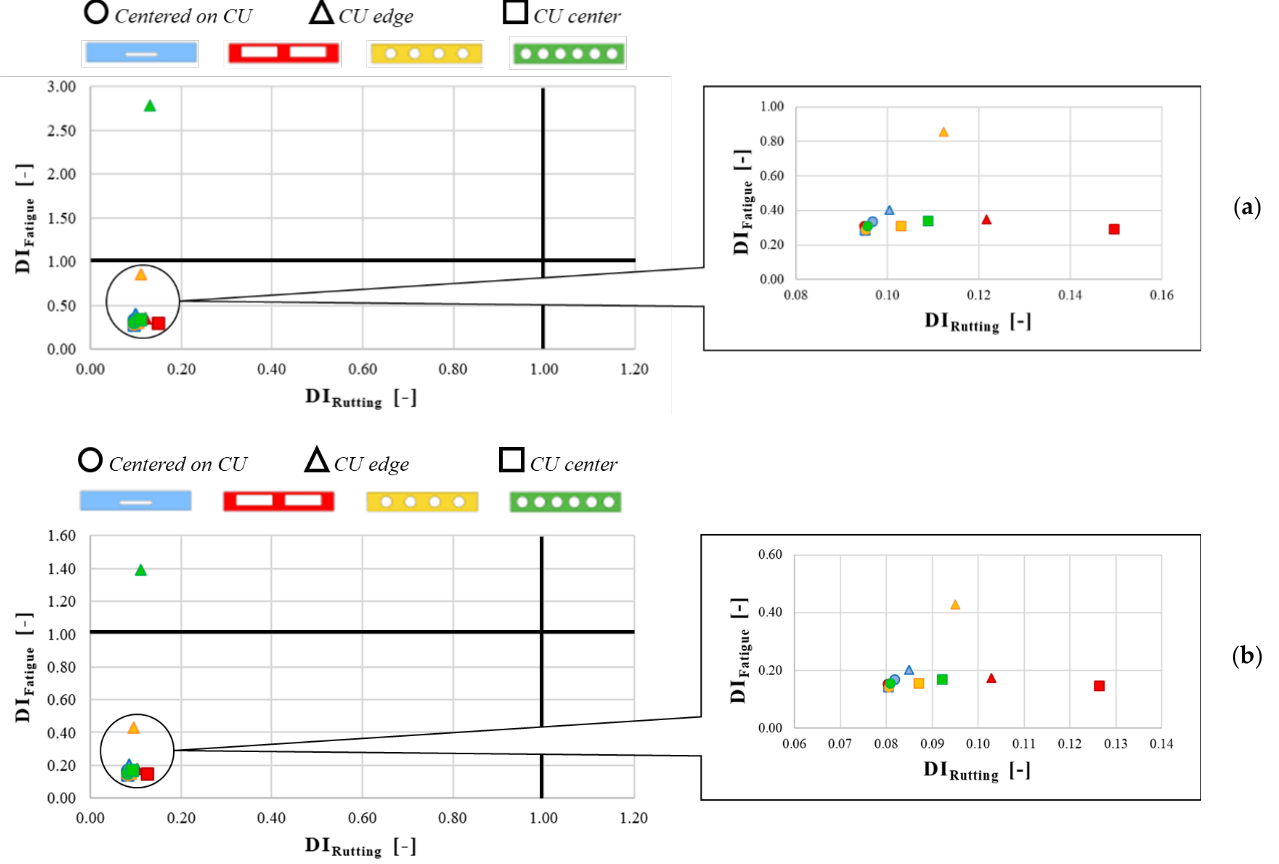
Figure 7. Comparison between DI Fatigue and DI Rutting values according to CU geometries and load positions considering ( a ) traffic on one lane; ( b ) traffic on two lanes.